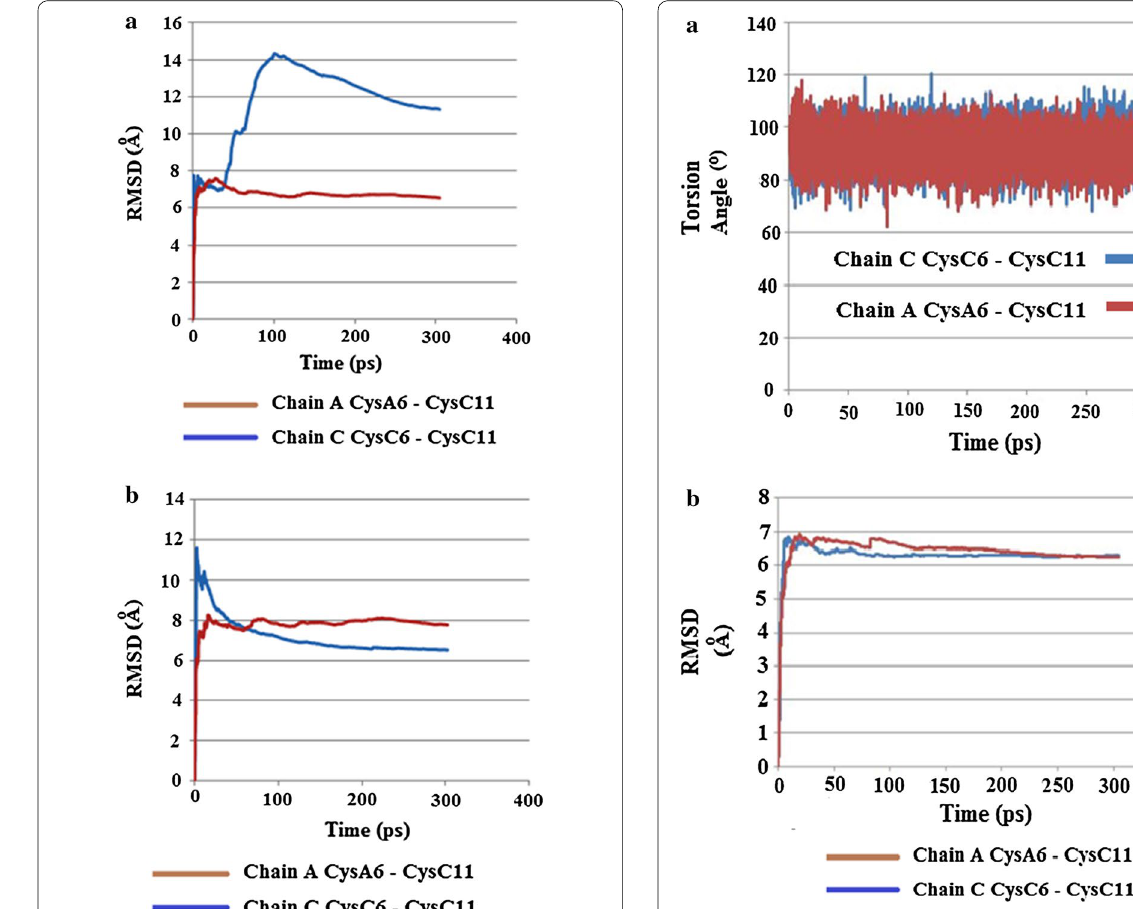
Fig. 24 a Plot of torsion angle χ3 changes for Cys6–Cys11 in chains A and C in HR insulin Intergen (II) 3W7Y for the MD simulation carried out at 310 K. b Plot of RMSD kinetics of Cys6–Cys11 torsion angles χ3 for the HR insulin Intergen (II) 3W7Y in chains A and C, respectively. MD simulations carried out at 310